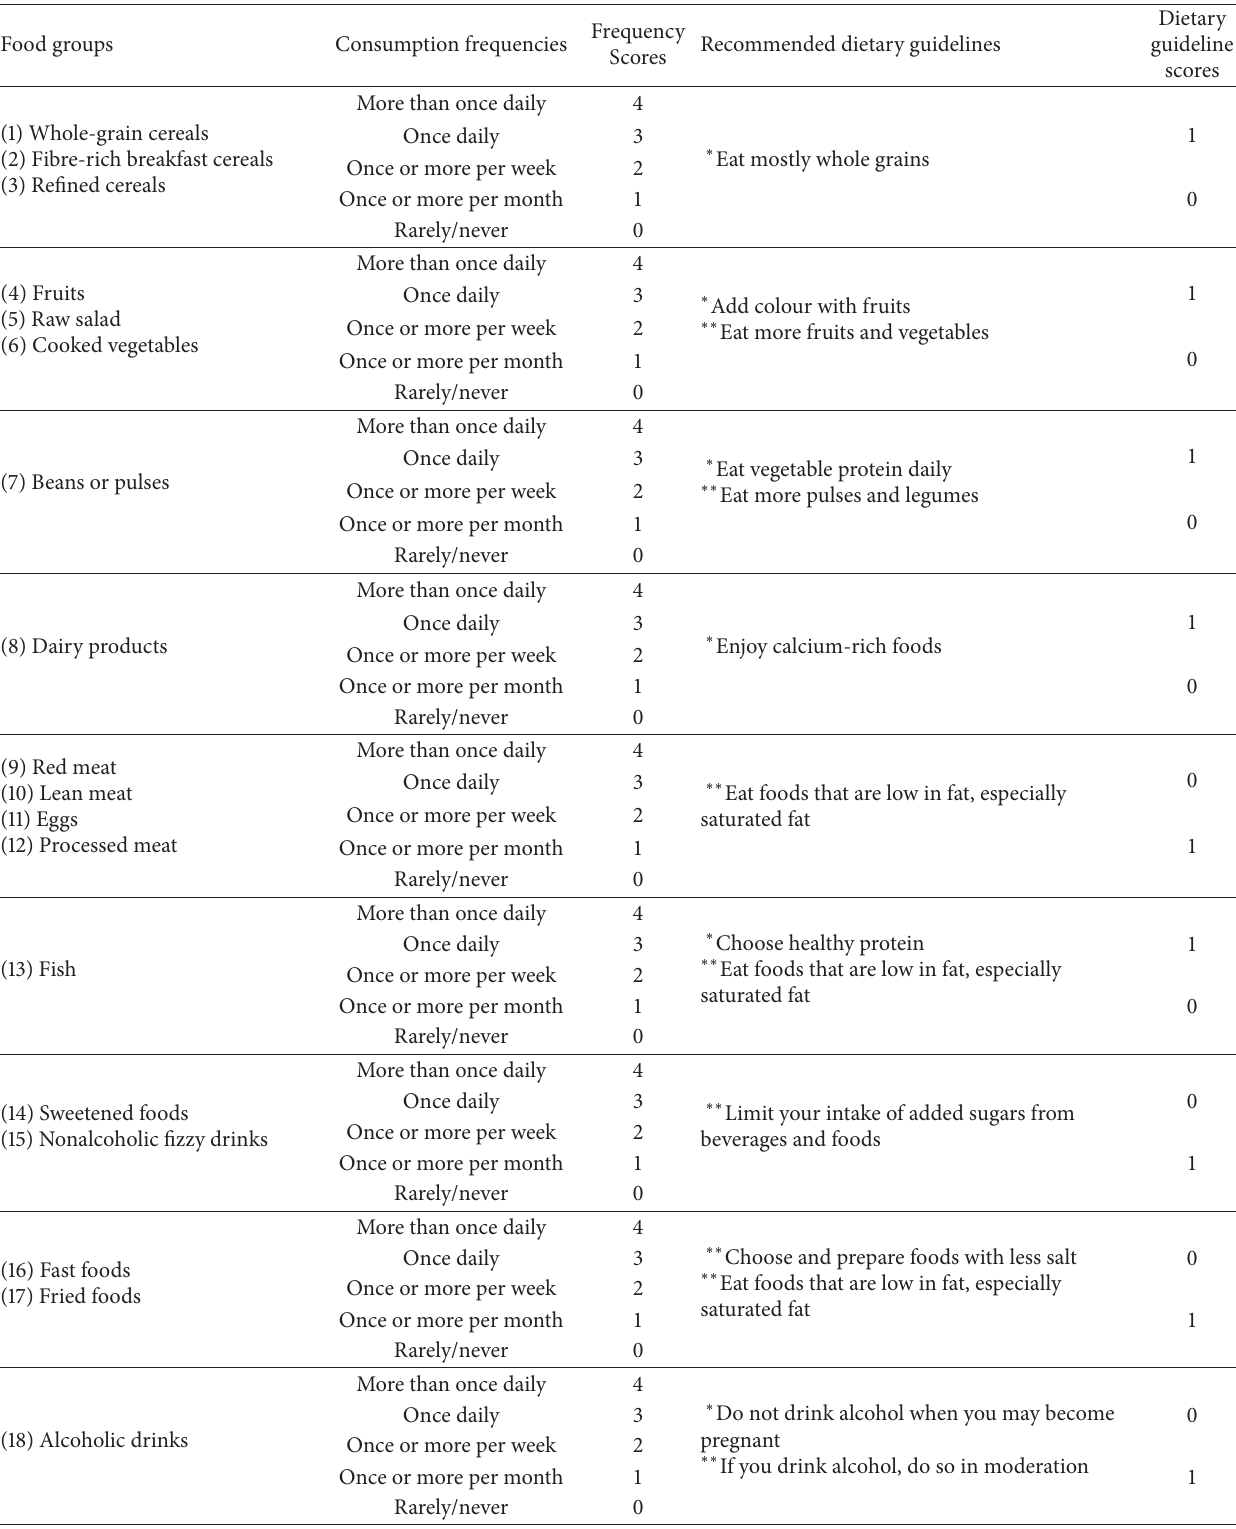
Table 1: Consumption frequency scores and dietary guideline scores for each food